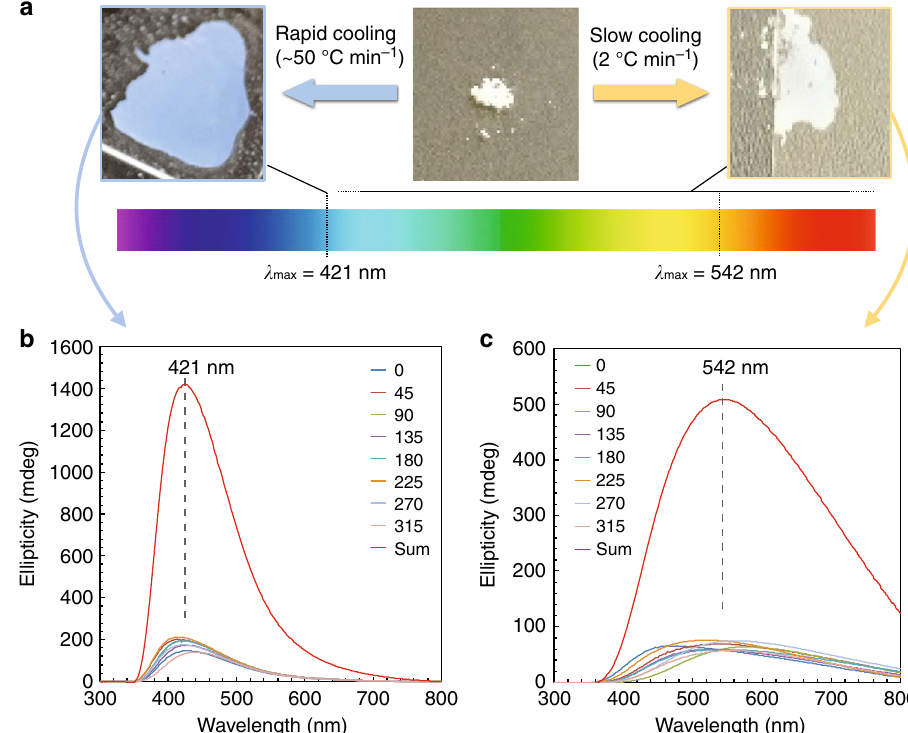
Fig. 4 Optical characterization. a Photographs of samples of neat 1 after recrystallization, after rapid cooling showing blue structural color, and after slow cooling at a rate of 2 °C min − 1 showing a very faint yellowish color that is dif fi cult to see. b , c Thin fi lm CD spectra of 10 μ m LC fi lms of compound 1 between untreated quartz substrates on cooling at different cooling rates from the isotropic liquid phase at different sample rotation angles as indicated in the legends (the red curve is the sum of all spectra to cancel out linear dichroism and birefringence): b rapidly cooled (quenched) sample; c sample cooled at a rate of 2 °C min − 1 . For larger plots of the individual CD spectra see Supplementary Note 7, Supplementary Figure